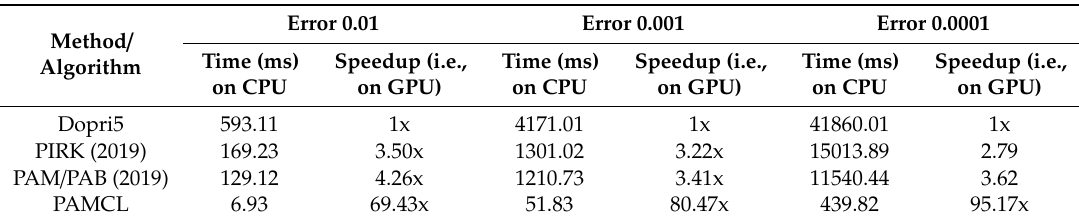
Table 3. Comparison of the “average computation times” on CPU and GPU while using di ff erent solver algorithms for solving the Rössler equation.